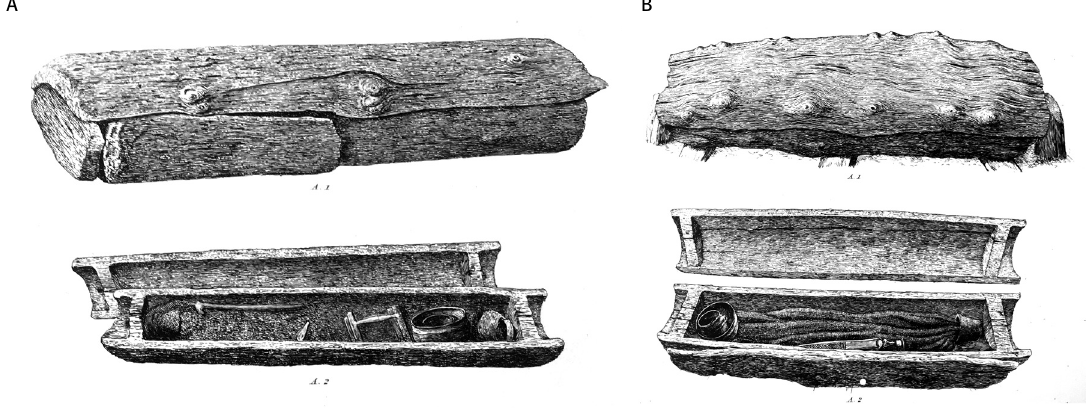
Figure 4. Two examples of oak coffin burials enclosed within additional trunks with bark and knots (A) Guldhøj, Denmark, (B) Store Kongshøj, Denmark. Drawings by: A.P. Madsen (modified after Boye, 1896, Pl. XIII and